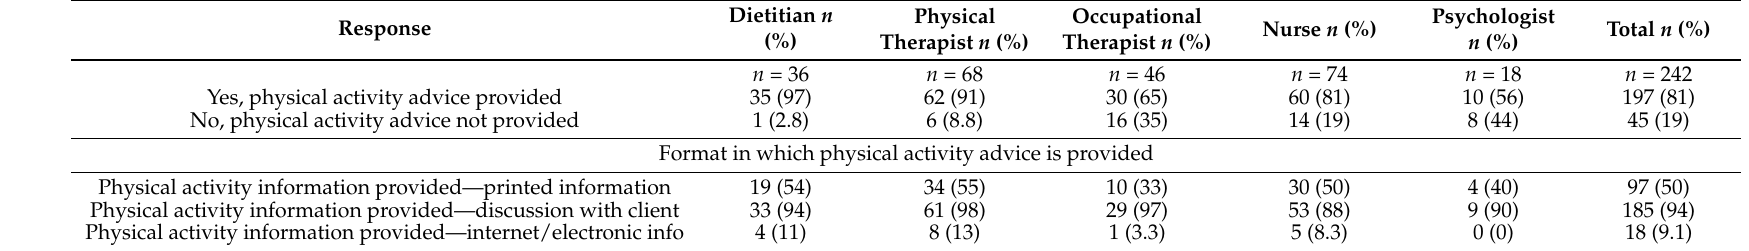
Table 5. Allied health professionals reported practices related to provision of physical activity advice for weight management.